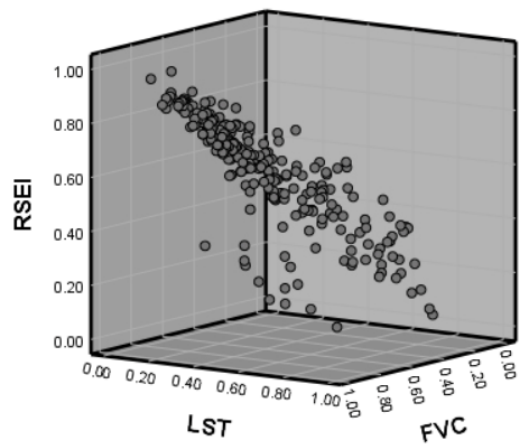
Figure 12. Three-dimensional spatial scatter plot.